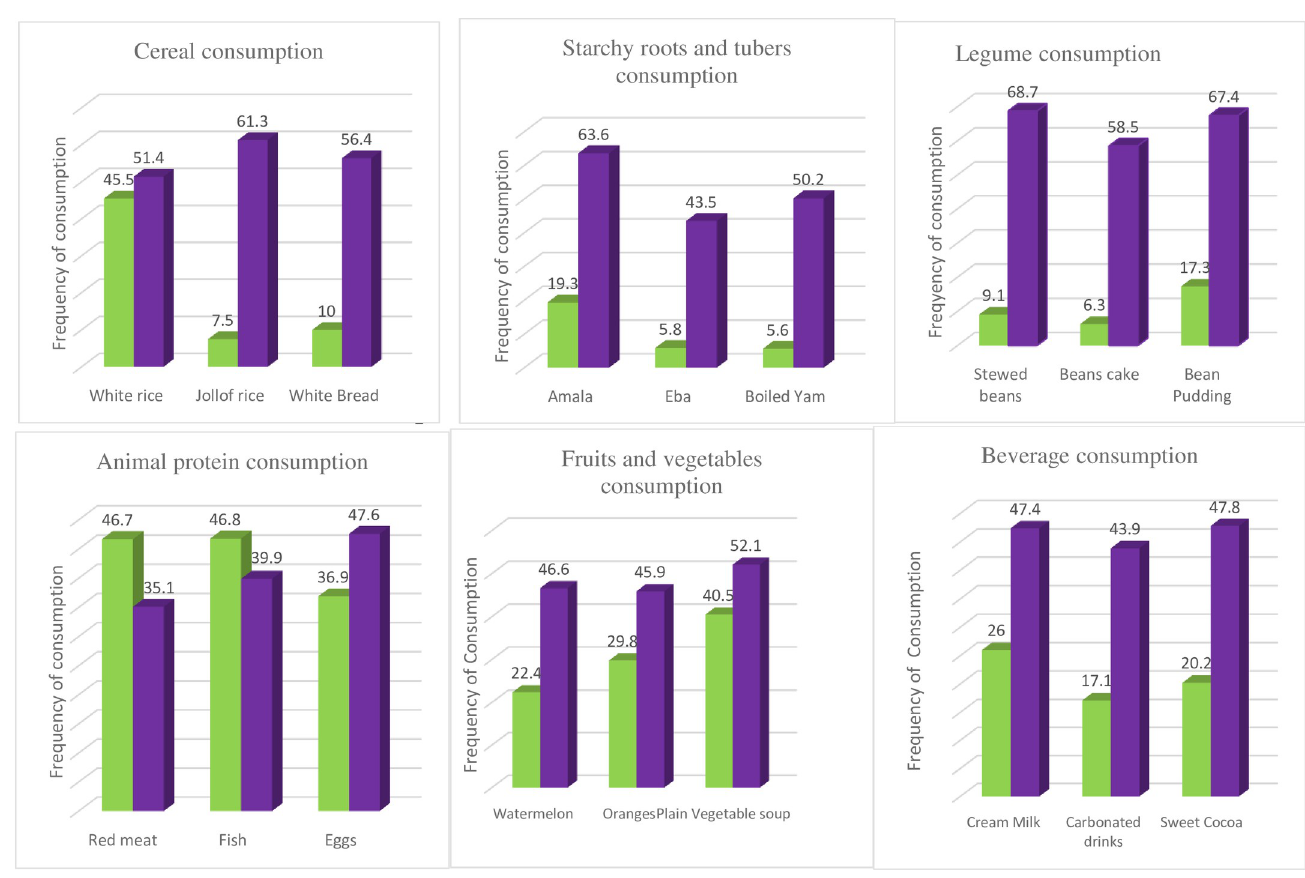
Fig 1. Most commonly consumed food items by food groups in the Ibadan pregnancy cohort daily (green); weekly